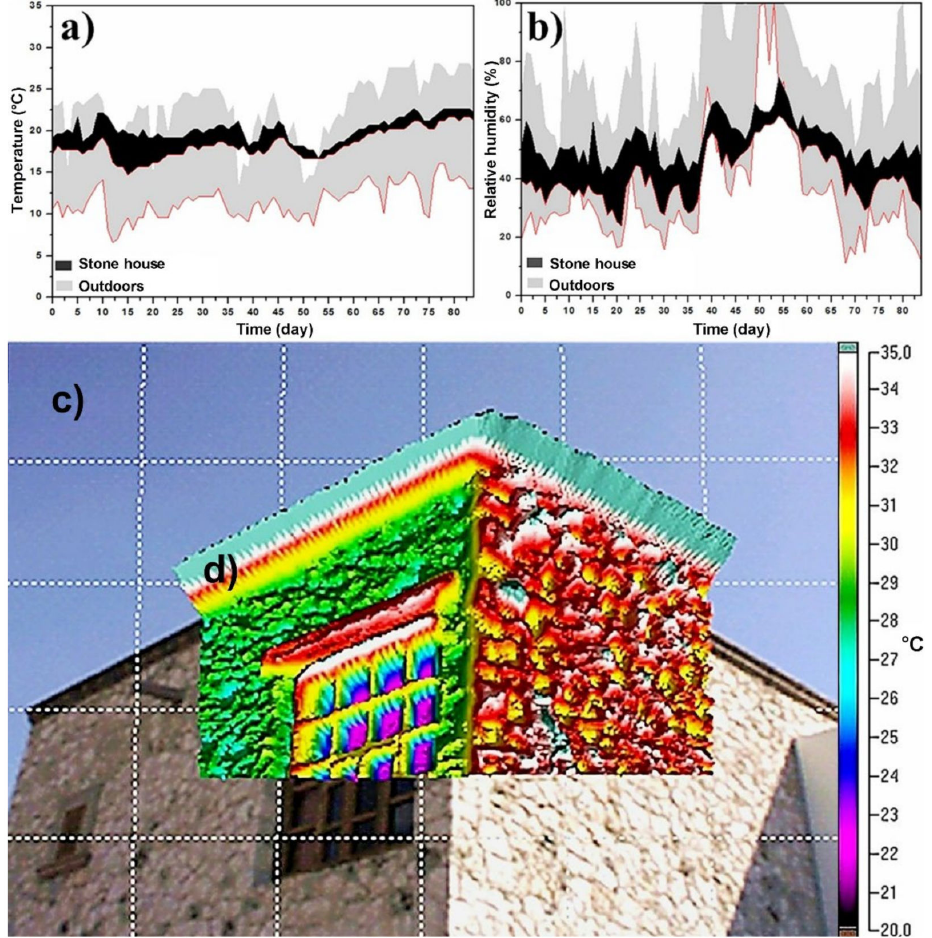
Figure 4. Quarterly graphs of the behavior of the stone house for ( a ) temperatures and ( b ) rela- tive humidities. ( c ) Porous stone house, two-floor and ( d ) inserted thermographic image of the stone